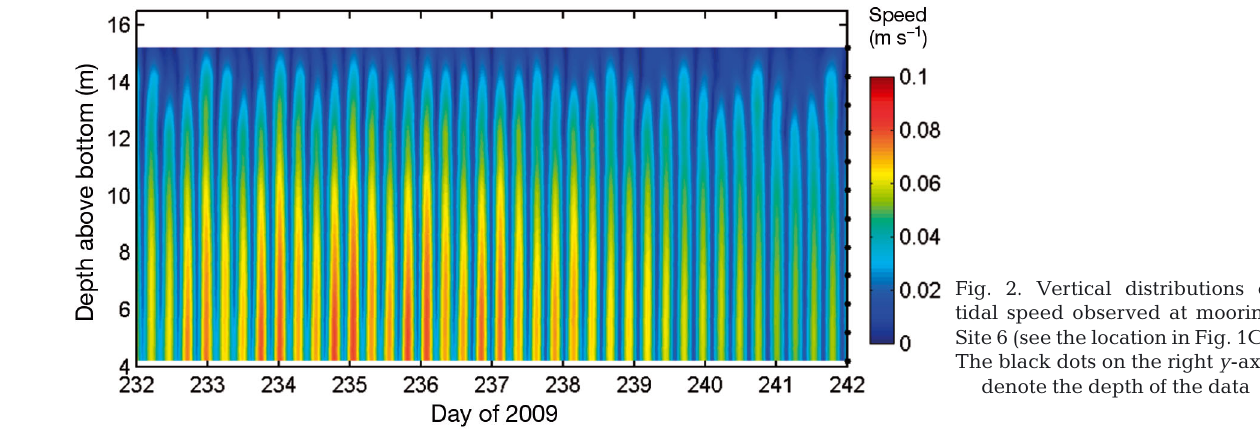
Fig. 2. Vertical distributions of tidal speed observed at mooring Site 6 (see the location in Fig. 1C). The black dots on the right y -axis